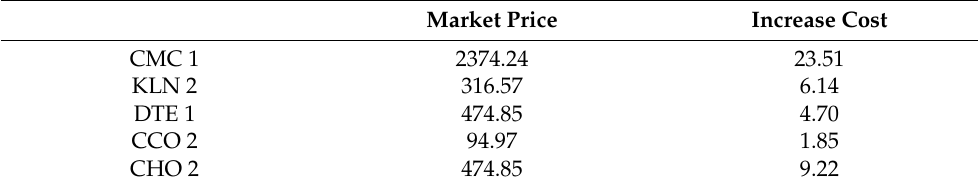
Table 7. Cost comparison of different additives